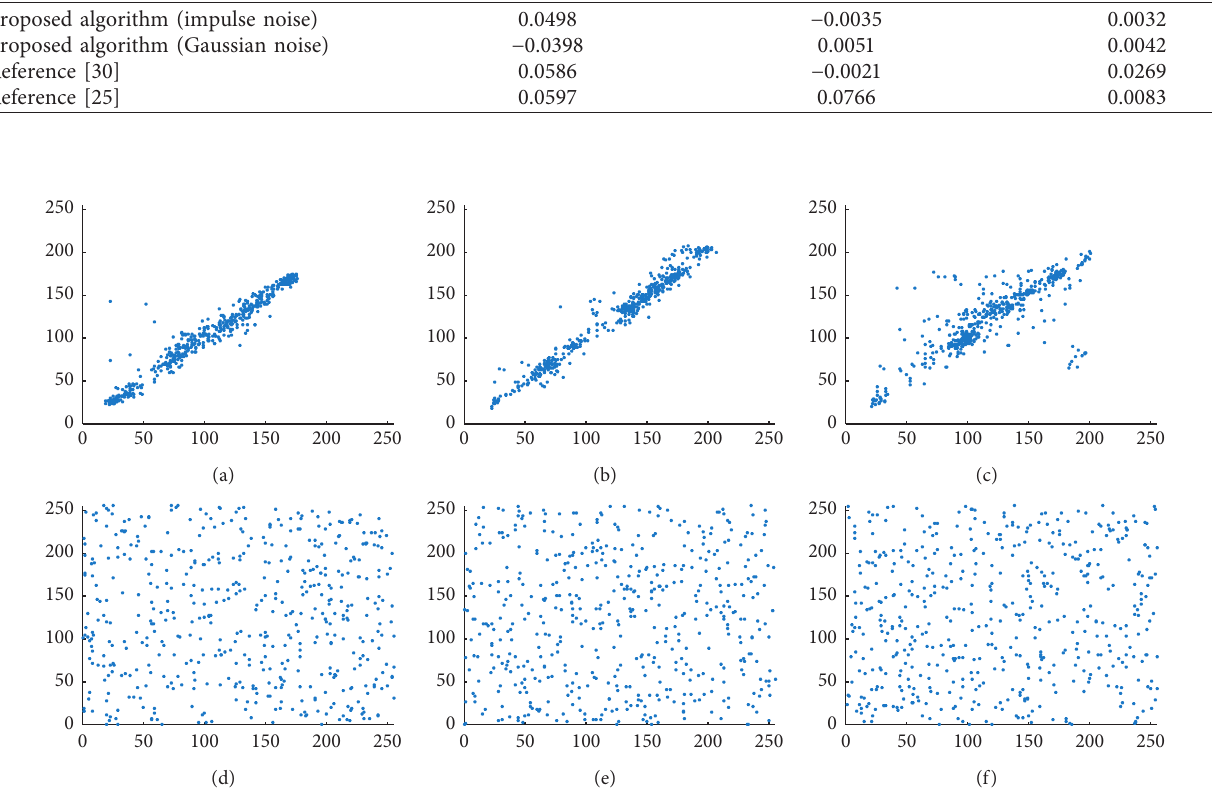
Figure 10: Distribution of adjacent pixels: (a) plaintext horizontal adjacent pixels, (b) plaintext vertical adjacent pixels, (c) plaintext diagonal adjacent pixels, (d) cipher text horizontal adjacent pixels, (e) cipher text vertical adjacent pixels, and (f) cipher text diagonal adjacent pixels.